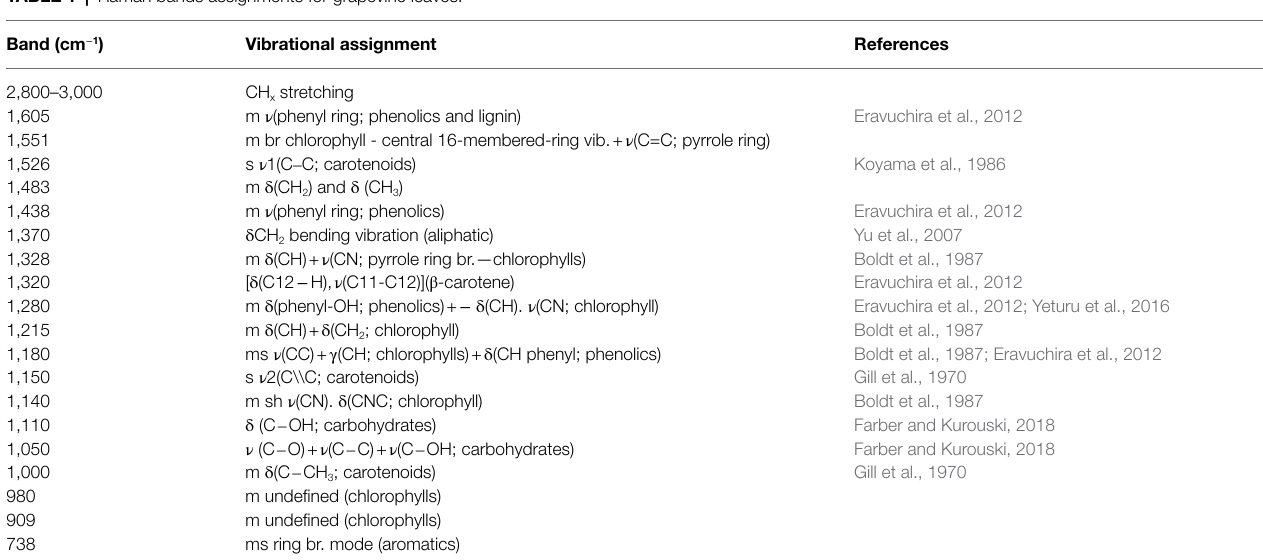
TABLE 1 | Raman bands assignments for grapevine